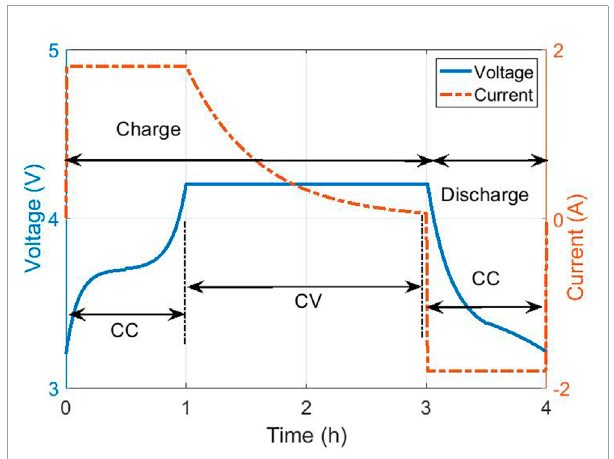
FIGURE 2 One cycle of constant current constant voltage (CC-CV) charge discharge